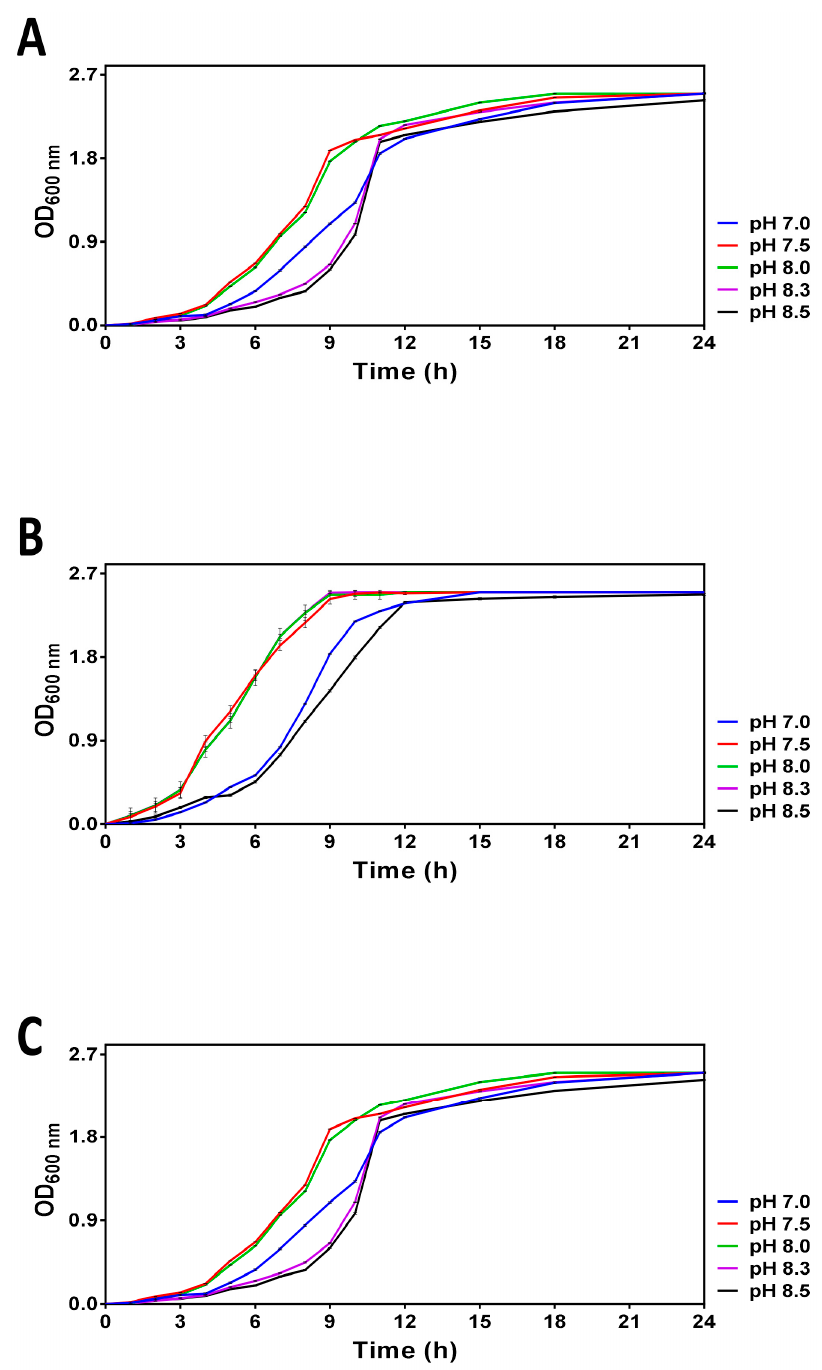
Figure 1. Growth curves obtained for V. harveyi grown in ASW medium with different pH (7.0, 7.5, 8.0, 8.3 and 8.5) at 20 ◦ C ( Panel A ), 25 ◦ C ( Panel B ) and 30 ◦ C ( Panel C ) as described in Section 2. Optical density was regularly measured at 600 nm within 24 h. The mean values and standard deviation (indicated by vertical bars) were calculated based on the data obtained in 3 independent